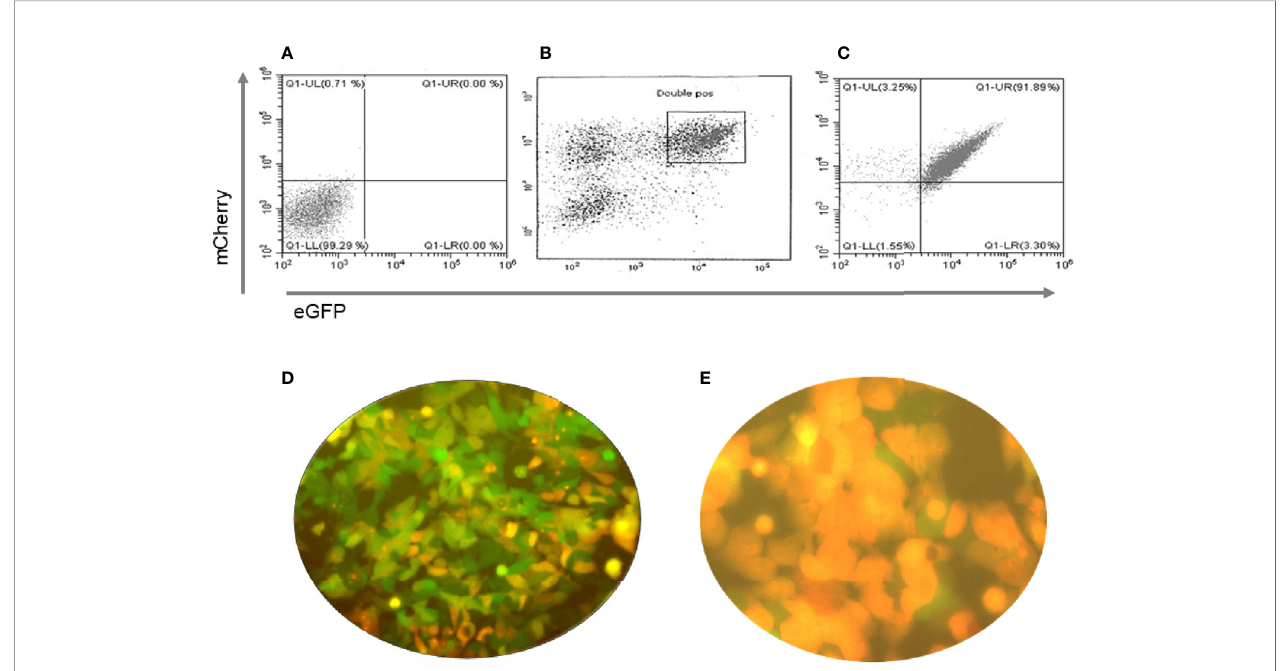
FIGURE 3 | Puri fi cation of double positive mES cells. These fi gures show the fl ow cytometry pro fi les of pre and post sorted mouse ES +/- cells. (A) Unstained mES, (B) eGFP and mCherry double positive gated cells for sorting (boxed) and (C) Post sorted cell analysis indicated 91.89% purity. (D, E) Immuno fl uorescence images of the cells before and after sorting of the cells for GFP and mCherry fl uorescence with the sorted cells being all double